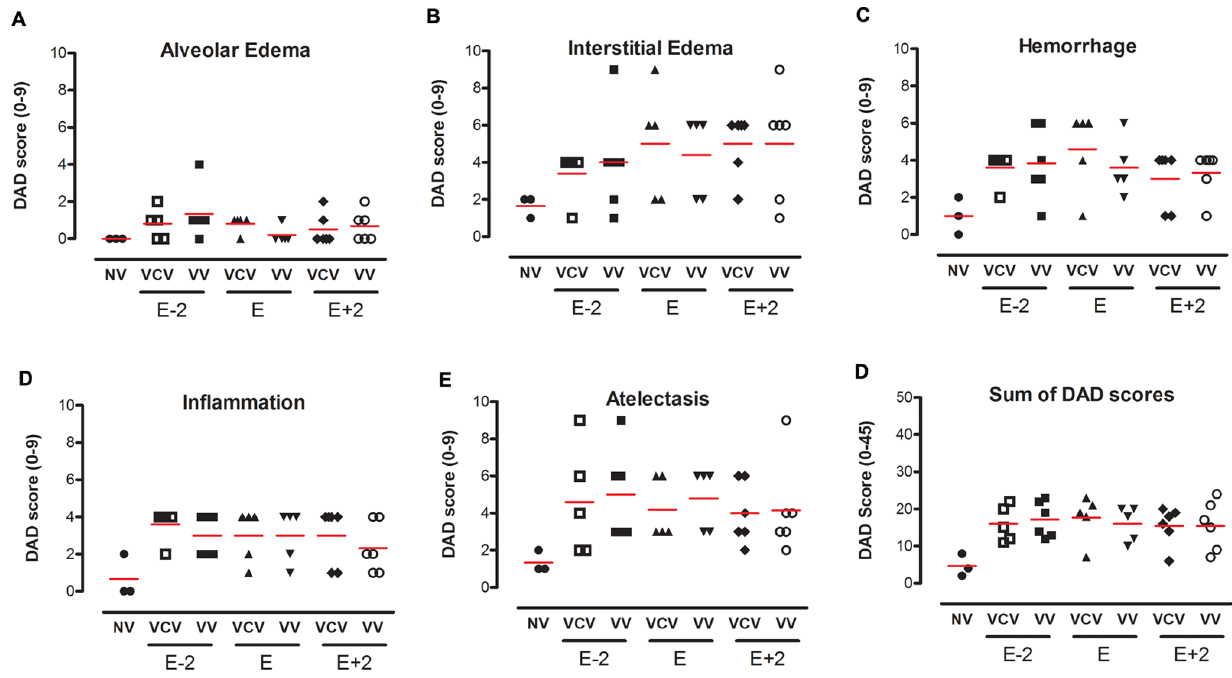
Figure 7. Plasmatic cytokines. Plasmatic concentration of TNF- a (A), IL-6 (B), CINC-1(C) and IL-1 b (D) ) in the groups: VCV_E (volume-controlled mode and PEEP minErs ; n=6), VCV_E + 2 (volume-controlled mode and PEEP minErs plus 2 cmH 2 O; n=6), VCV_E-2 (volume-controlled mode and PEEP minErs minus 2 cmH 2 O; n=6), VV_E (variable ventilation and PEEP minErs ; n=6), VV_E + 2 (variable ventilation and PEEP minErs plus 2 cmH 2 O; n=5), VV_E-2 (variable ventilation and PEEP minErs minus 2 cmH 2 O; n=6). Red lines represent mean values. Ventilatory mode and PEEP effects were tested with two-way ANOVA followed by Tukey post hoc. T-test was used to detect differences between ventilated and non-ventilated groups and then correction by multiple comparison. Statistical significance was accepted at p , 0.05. *p ,